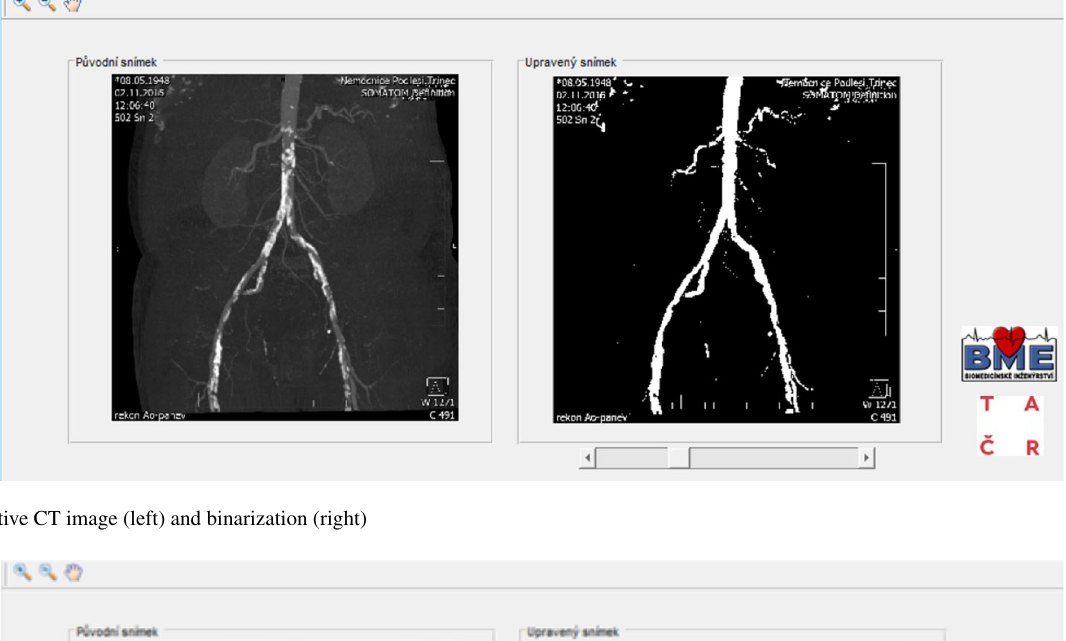
Fig. 7 Native CT image (left) and binarization (right)